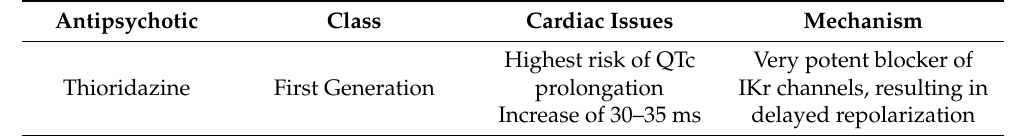
Table 1. Cardiac Issues and